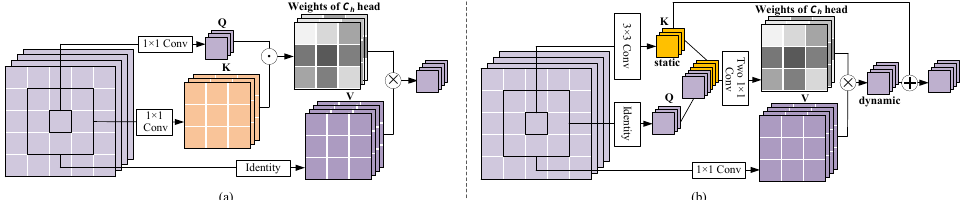
Figure 1. The multi-head structures of ( a ) local relation self-attention block and ( b ) CoT block. (cid:12) denotes dot product, ⊗ denotes local matrix multiplication with channel sharing, and ⊕ denotes element-wise